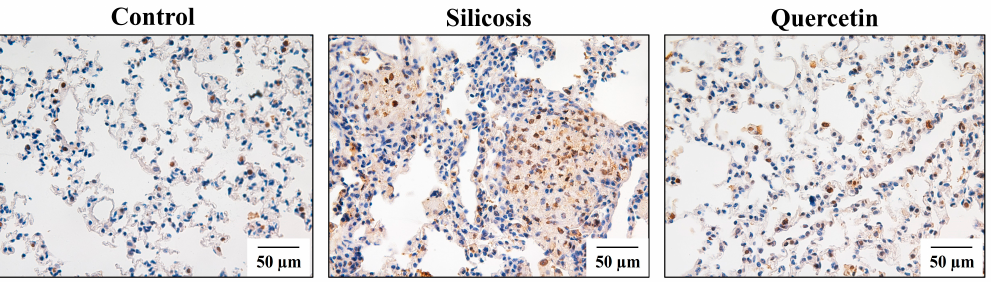
Figure 14. The expression of p-Smad 2/3 in the lung was observed by immunohistochemical staining (scale bar = 50 µm).